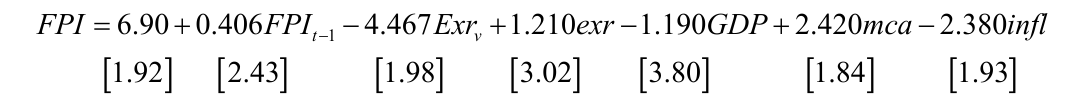
Table A5. Variance decomposition